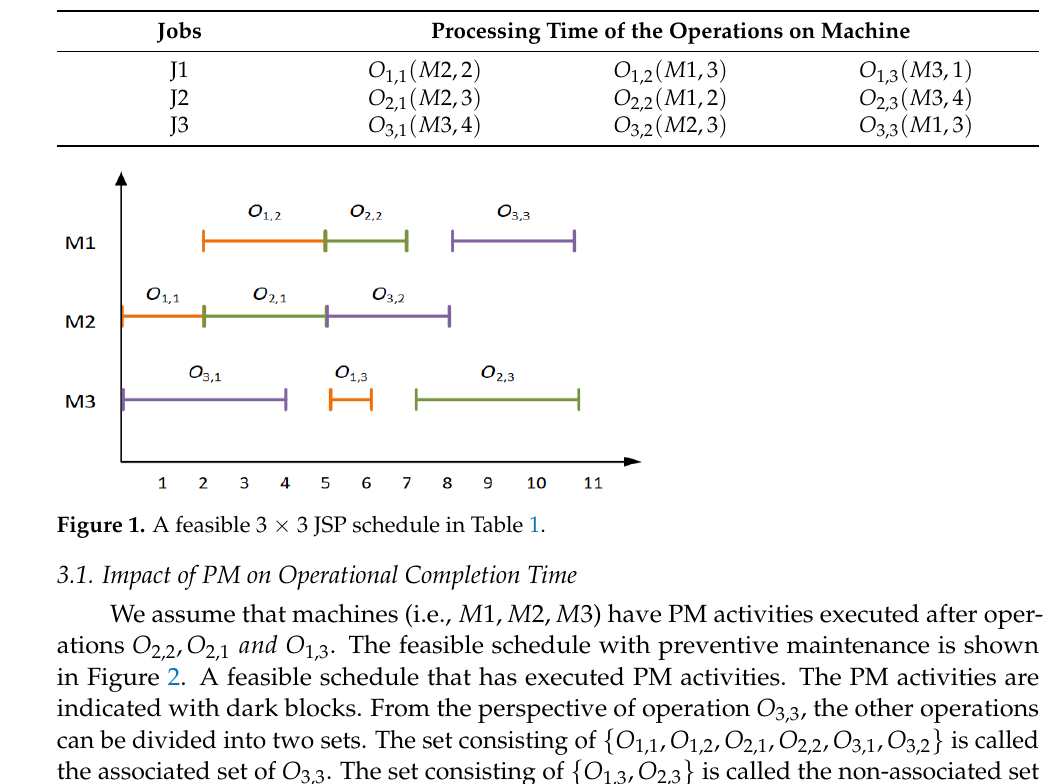
Table 1. Process table for a JSP problem with size 3 × 3.